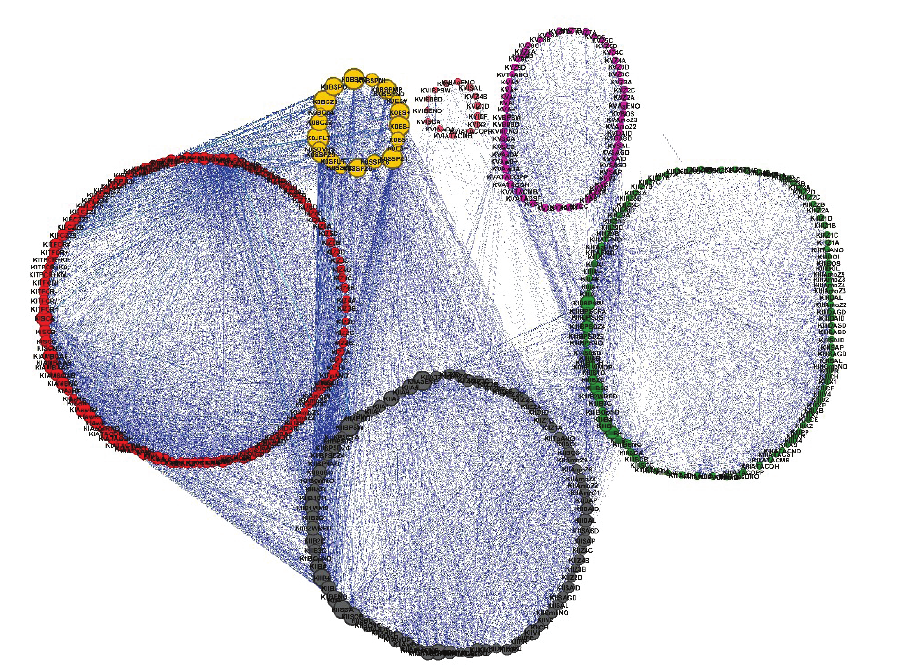
FIGURE 1. Network of the six complexes, with Eigenvector Centrality. Terminology: On each node, the codes are represented by the name of the complex, followed by the variable and its category. For example, KIIATACOH indicates that the action occurred in complex II, the variable in question was the function of the attacker, in this case, the outside hitter. The codes for the different variables: SSP – server starting position; S – type of serve; BC – screening block; BSP – block starting point; SE – serve efficacy; RL – reception line; RJP – player’s reception function; FCZ – first contact zone; TFC – type of first contact; SC – setting conditions; AMB – availability of the middle-blocker; AAEWEX – attack after or without receive/defend; ATAC – attacker function; CMB – combination of attack; ATZ – attack trajectory zone; TpA – type of attack; AAE – attack after error; AE – attack efficacy; BPS – behaviour prior to the setting action; BOp – block opposition; BE – block efficacy. The EC values corresponding to each of the variables per complex are expressed in Table 2. In the K0, we highlight the values of; the jump-float serve, of serving from Z1, of the block screening in Z3, and serve efficacy being negative or positive. In KI, the most used was ideal setting conditions compared to the non-ideal. The most requested player in side-out was the OH, followed by OPP and MB. Concerning the attack, mostly it was without receiving but with the perfect ball followed by without receiving but with the positive ball. In situations in which the attacker received a perfect or positive ball and then attacked, the attackers sought to attack directed to the parallel, soft spike in Z9, or explored the block. Conversely, the attack tempo was fast on the Z4, slow on Z2 and the MB to attack CF and CH. In turn, the type of attack was either a strong attack on the parallel, a paragonal-directed attack, a great crosscourt or a crosscourt intermediate attack with a great efficacy of attack. As for the attack after two collective errors, the players sought the most controlled attack on the small crosscourt and the soft spike (Z3 and